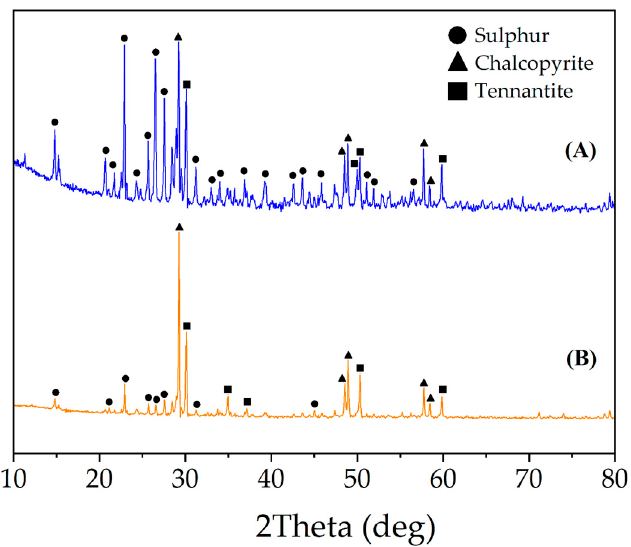
Figure 7. SEM images of synthetic concentrate-leaching residue ( a , b ) and EDX-mapping of the residue for Fe ( c ), Cu ( d ), S ( e ) and combined ( f ). (300 rpm; 353 K; 6 mol/L H 2 SO 4 ; 0.018 mol/L Fe (III); 60 min; FeS 2 /synt. conc = 1/1).